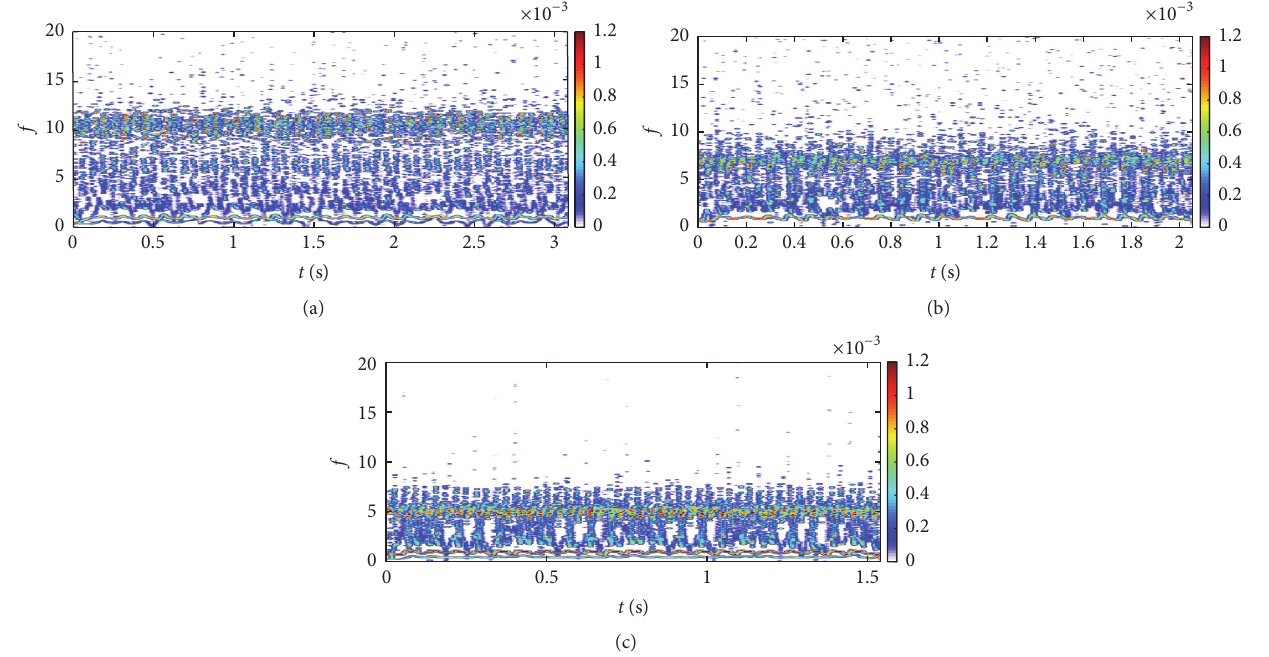
Figure 16: Time-frequency diagrams of the faulted system at (a) 100 rad/s, (b) 150 rad/s, and (c) 200 rad/s.